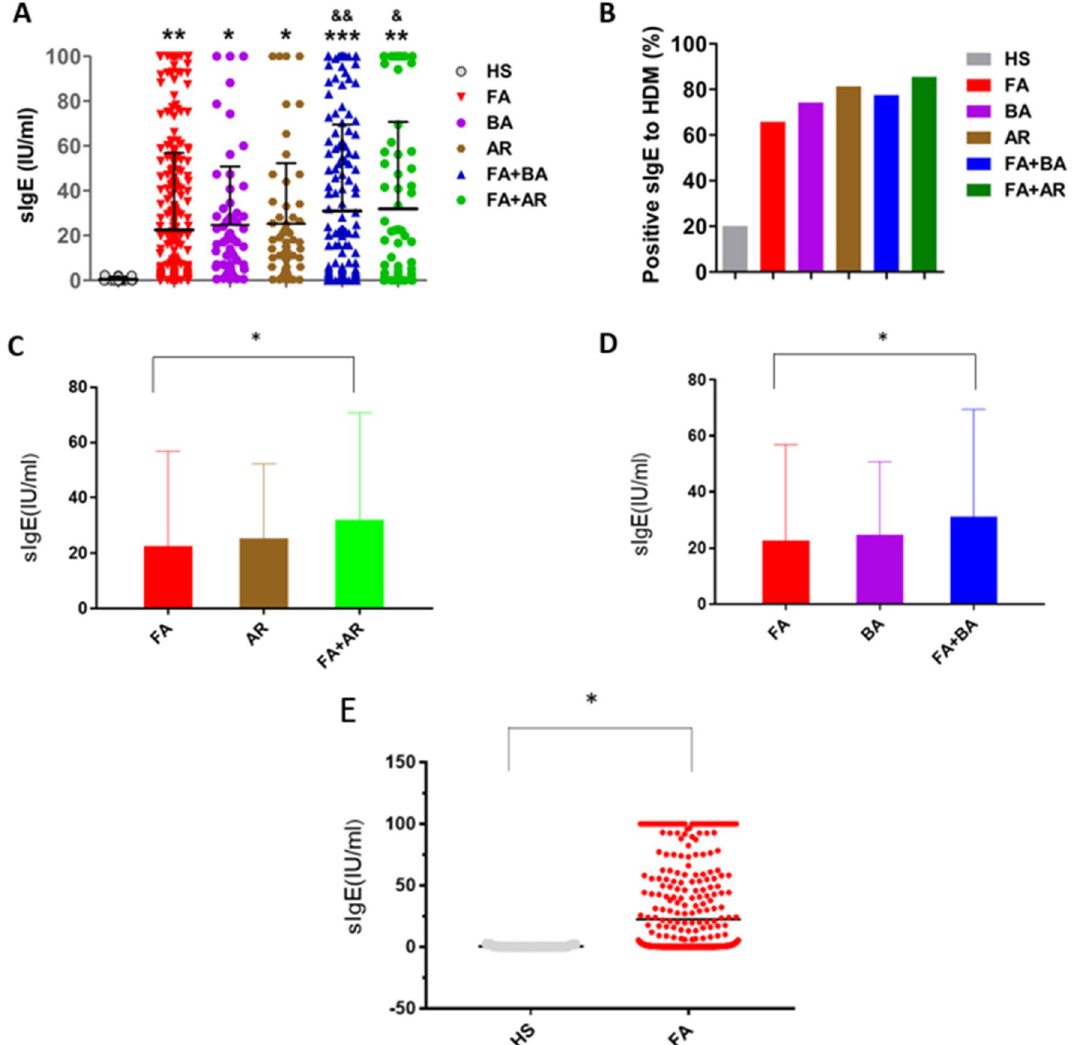
allergic dermatitis and allergic rhinitis, 403 cases; BA (bronchial asthma), 61 cases; AR (allergic rhinitis), 59 cases; FA + BA (food allergy with asthma), 223 cases; FA + AR (Food allergy with allergic rhinitis), 83 cases. ( A ) the levels of IgE against HDM. ( B ) the percentage of IgE against HDM. Those with HDM-sIgE level > 0.35 IU/ ml were regarded as IgE positive. ( C – E ) the levels of IgE against HDM. FA + AR (Food allergy with allergic rhinitis), FA + BA (food allergy with asthma), FA (food allergy) without asthma, allergic dermatitis and allergic rhinitis. * p < 0.05, ** p < 0.01, *** p < 0.001, **** p < 0.001, (ANOVA) compared with the HS group, and & p < 0.05, && p < 0.01 compared with the FA